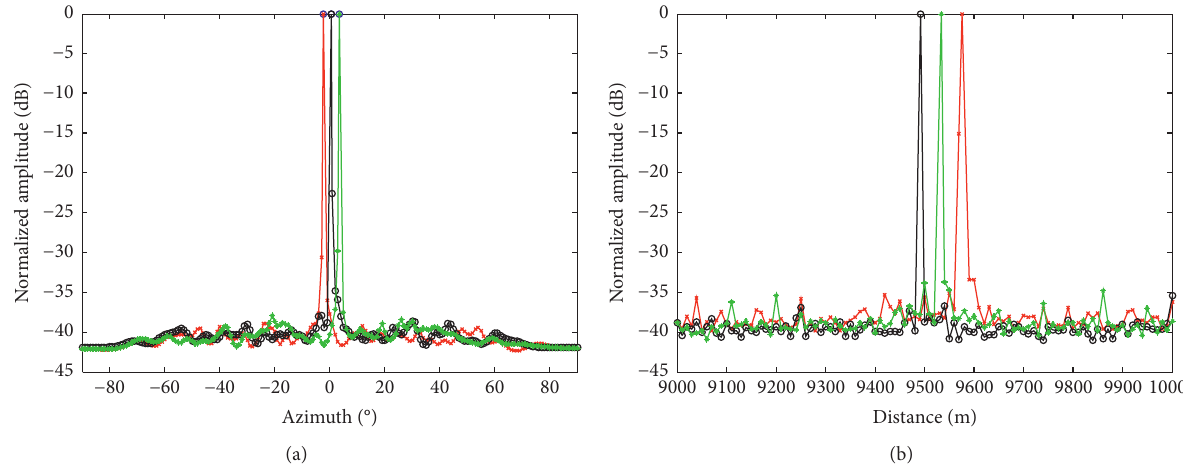
Figure 7: Three sources of angle-distance estimation results: (a) three sources azimuth estimates and (b) three sources distance